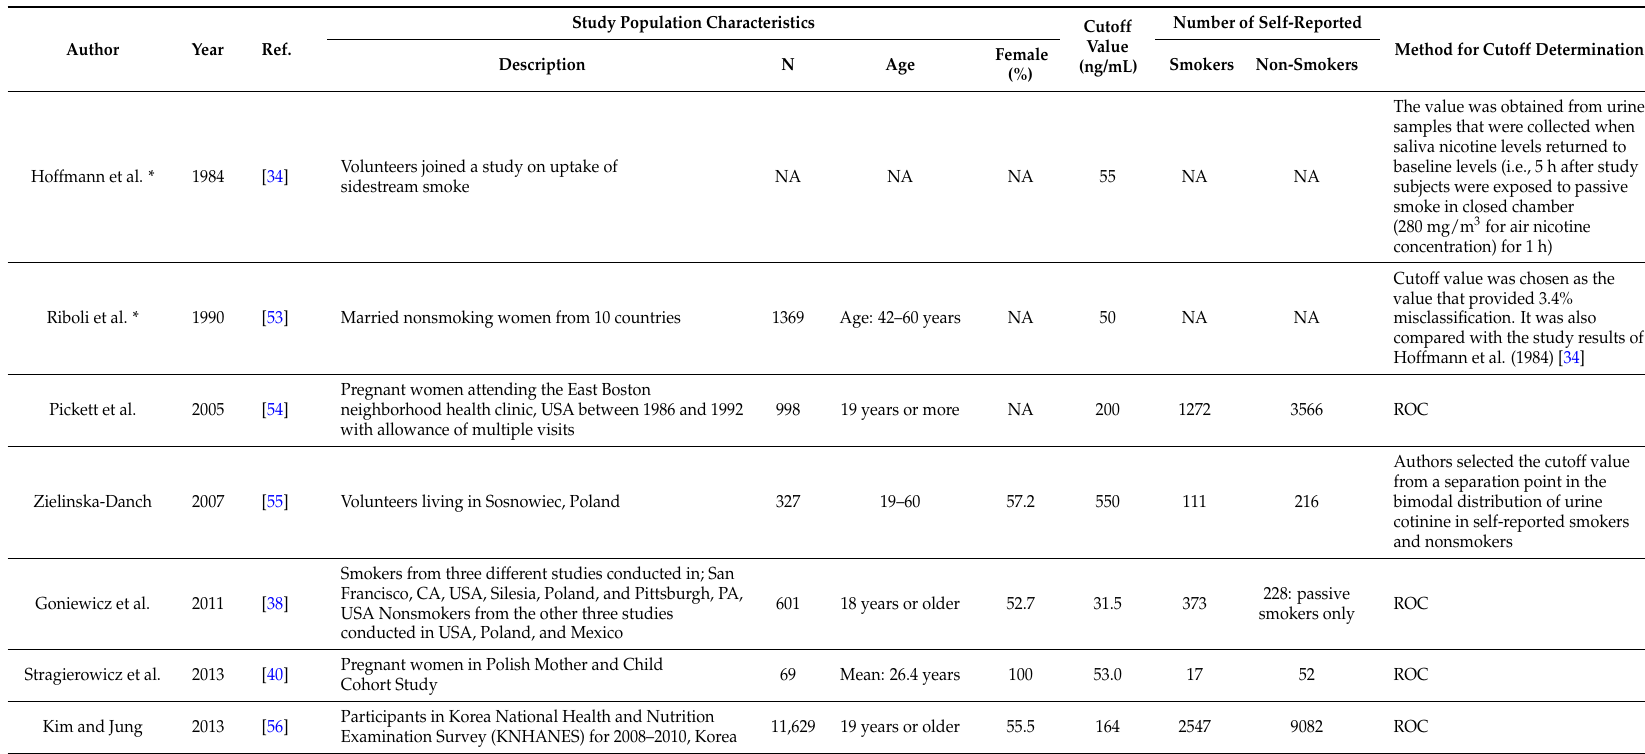
Table 3. Urine cotinine cutoff values and methods of